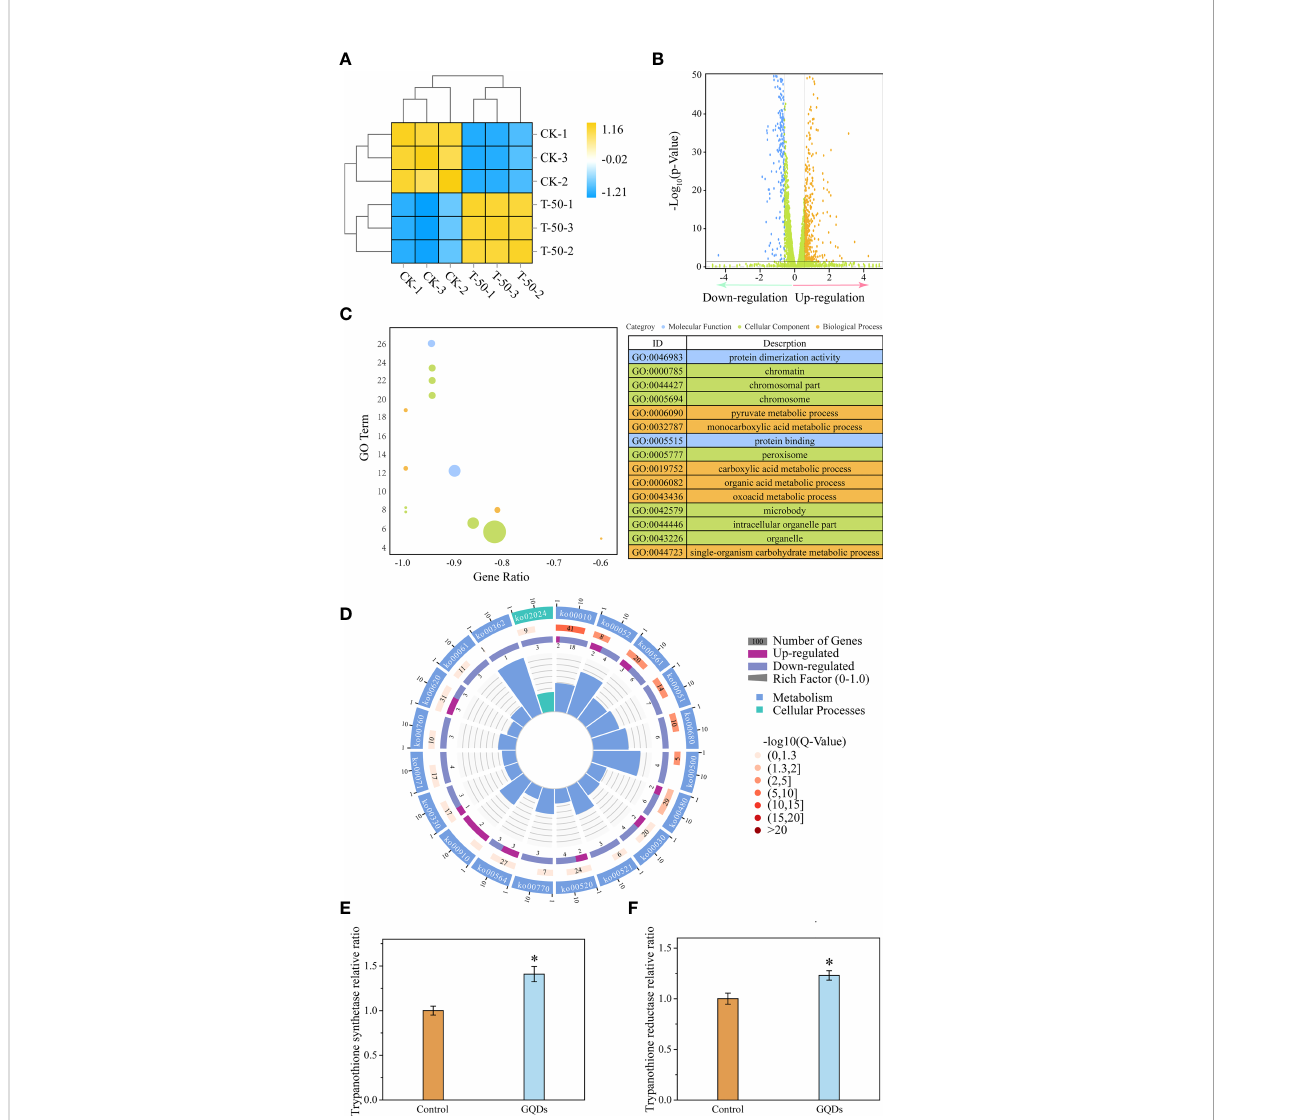
FIGURE 5 Transcriptomic analysis and key genes related to the redox function of Trypanosoma brucei after exposure to graphene quantum dots (GQDs). (A) Correlation analysis of the transcriptomic data between GQDs-treated parasites and controls following treatment in T. brucei . CK-1 , CK-2 , and CK-3 represent triplicate samples without GQDs treatment. T-50-1 , T-50-2 , and T-50-3 represent triplicate samples treated with GQDs (50 m g/ml). Orange indicates positive correlation, while blue denotes negative correlation. (B) Distribution of the differentially expressed genes (DEGs) after exposure to GQDs. For transcriptomic analysis, normalized data were p ≤ 0.05 (Dataset S1). Brown color represents upregulated genes, blue indicates downregulated genes, and green represents the genes without signi fi cant changes. A false discovery rate ≤ 0.05 and fold change ≥ 1.5 were used as the thresholds for DEGs. (C) Top 15 enriched Gene Ontology (GO) terms based on the DEGs following GQDs treatment in T. brucei (Dataset S2). (D) Corresponding pathways signi fi cantly enriched based on the DEGs after exposure to GQDs in T. bruce i. For transcriptomic analysis, normalized data were p ≤ 0.05 (Dataset S3). (E, F) Transcriptional analysis of the trypanothione synthase (E) and trypanothione reductase (F) of T. brucei following treatment with GQDs by quantitative reverse transcription PCR (qRT-PCR). The GADPH gene served as a standardization control. Values are the mean ± SD of triplicates. Student ’ s t -test was used to obtain p -values. * p < 0.05 (compared to the